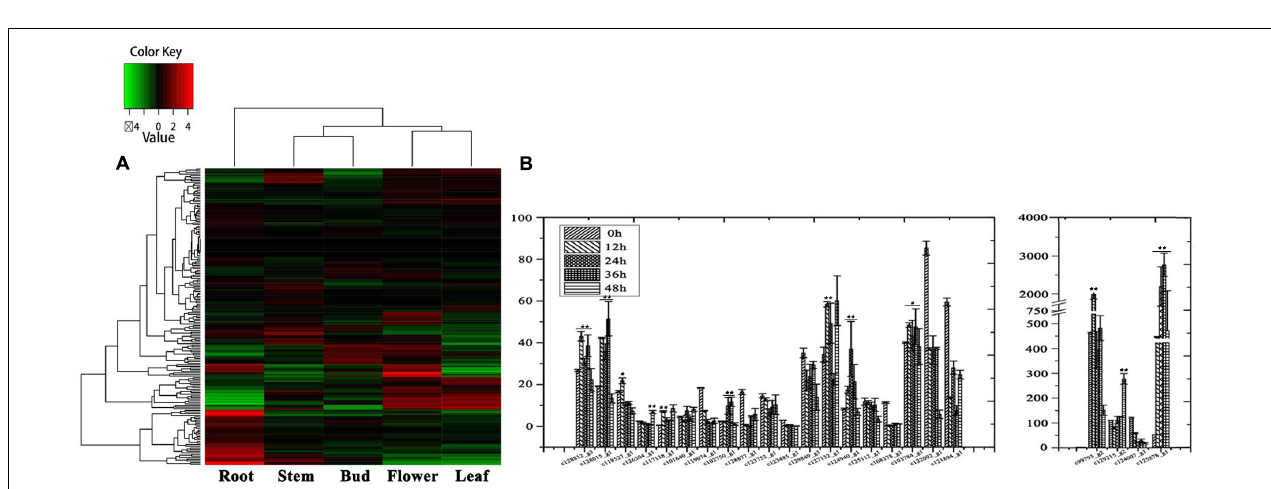
FIGURE 6 | Expression analysis of the P450 genes. (A) Organ-specific expression analysis of the P450 genes in D. nipponica . (B) Expression analysis of the P450 genes highly expressed in roots in MeJA-treated organs. Error bars are SD. Statistical significance was determined by Student’s t -test ( ∗ p ≤ 0.01; ∗∗ p ≤